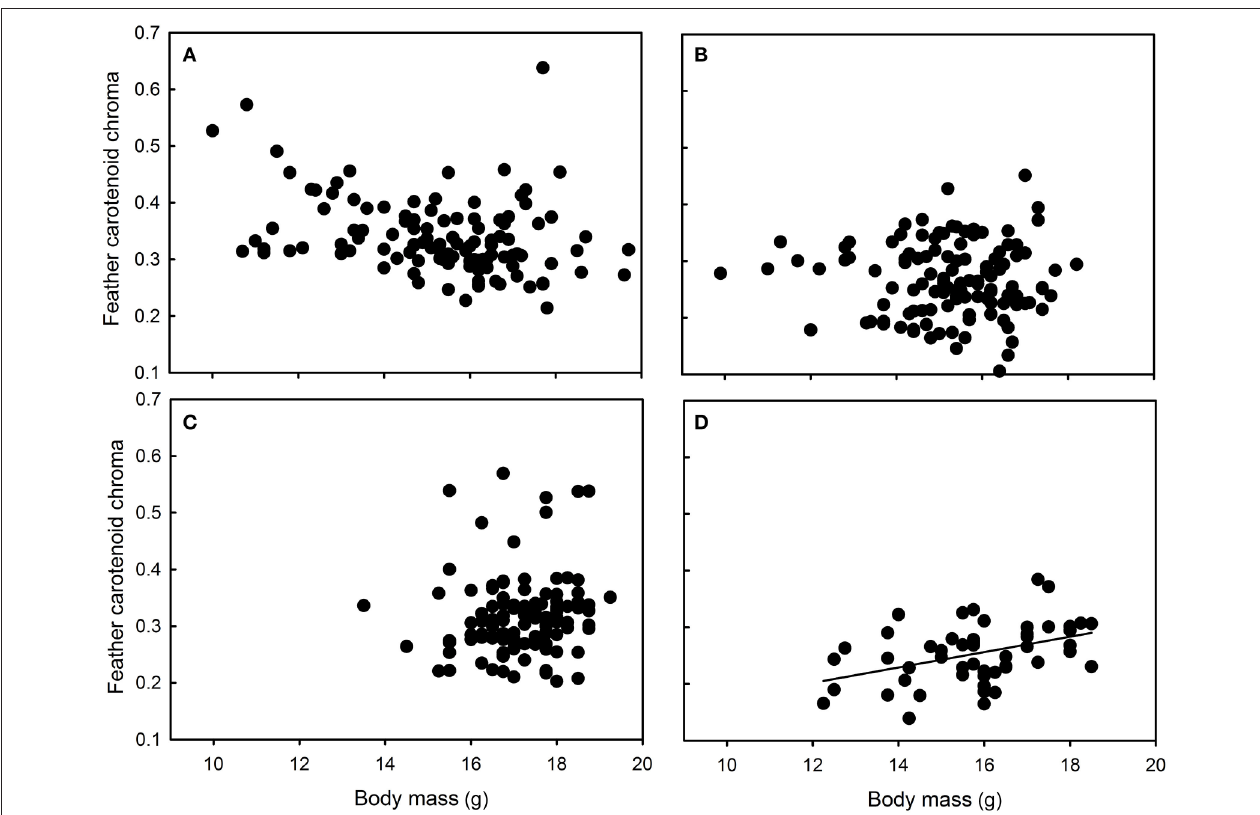
FIGURE 4 | Relationships between feather carotenoid chroma and body mass in great tit nestlings reared in (A) Chizé and (B) Niort, (C) Foljuif, and (D) Paris. For information, the marginally negative relationship in Chizé (see text for details), turned significant when the seemingly outlier data point is excluded [ F (1, 97) = 8.38, p = 0.005, estimate ± s.e. = − 0.03 ± 0.01). There was however no biological or methodological reason to exclude a posteriori this nestling from the data